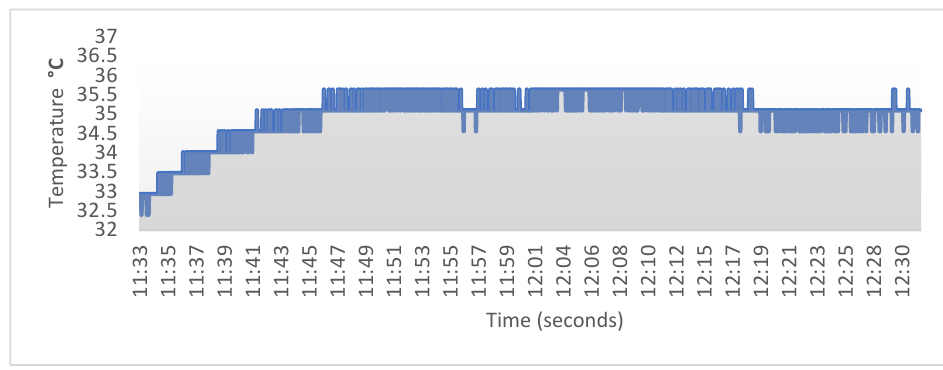
Figure 8. Morning Temperature signal .